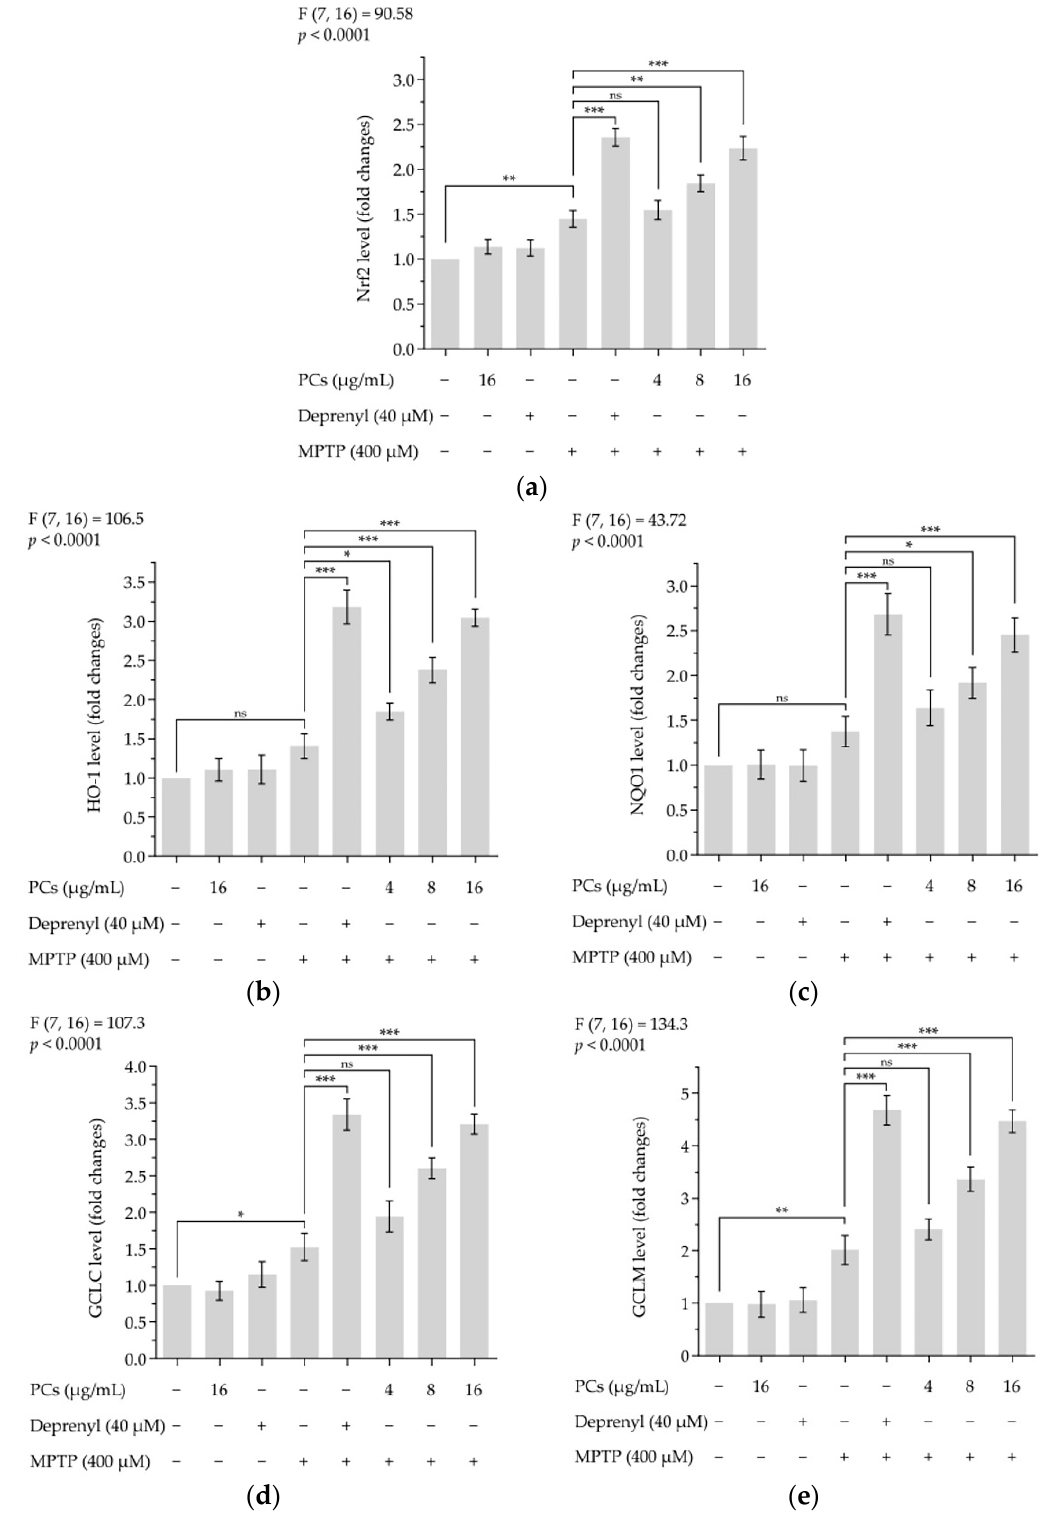
Figure 8. Effects of PCs on Nrf2/ARE pathway in MPTP-induced zebrafish larvae. ( a ) Nrf2 levels; ( b ) HO-1 levels; ( c ) NQO1 levels; ( d ) GCLC levels; ( e ) GCLM levels. F and p values of the one-way analysis of variance are presented above each chart. The results of Tukey’s post hoc test are presented for selected comparisons: ns, p > 0.05; *, p < 0.05; **, p < 0.01; ***, p < 0.001; the error bars are SD.